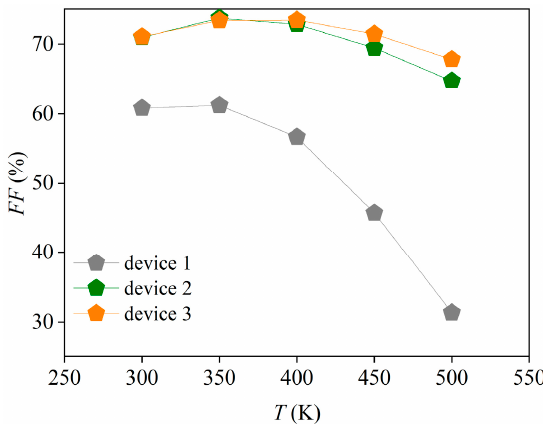
Figure 20. Effects of temperature on the cell fill factor.